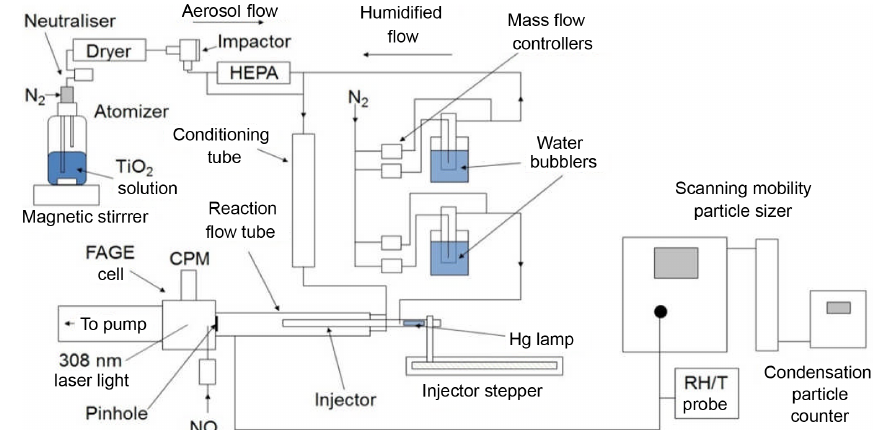
Figure 1. Schematic diagram of the aerosol flow tube experiment. CPM: channel photomultiplier; HEPA: high-efficiency particulate air filter; FAGE: fluorescence assay by gas expansion; RH/ T : relative